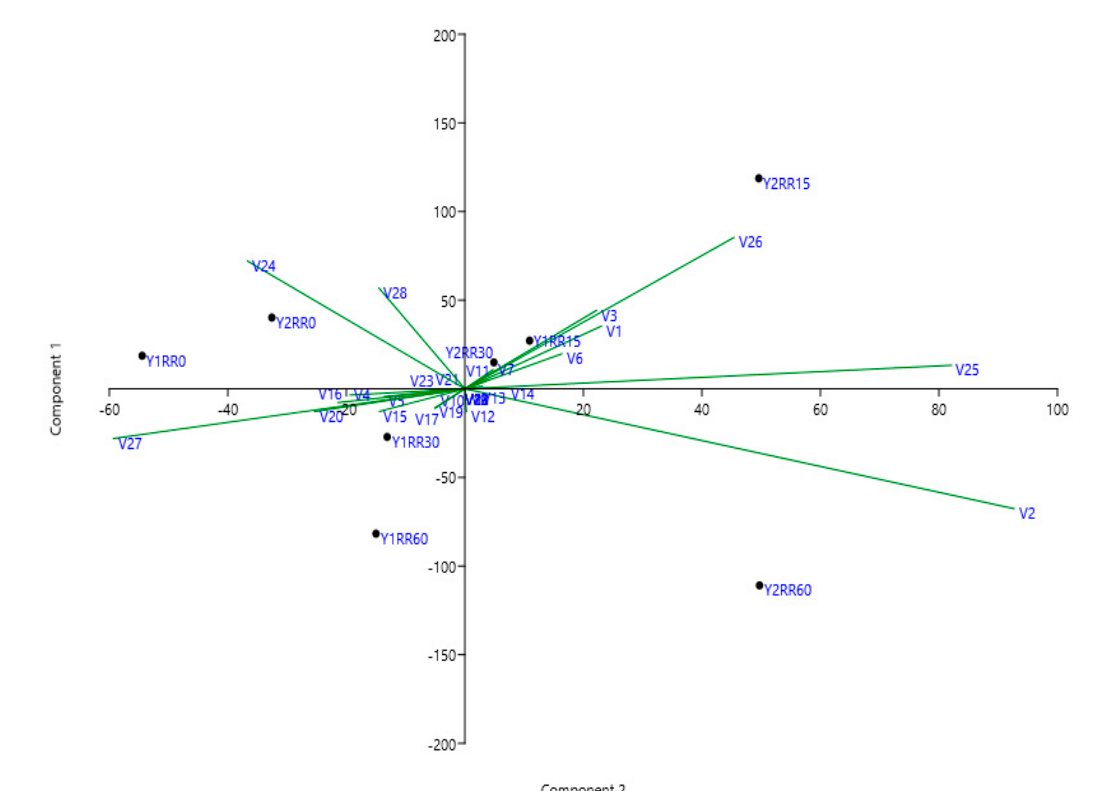
WP = weak perennial, P = perennial, Ave = average, + = appearing in one of the five replicates, ++ = appearing in two of the five replicates, +++ = appearing in three of the five replicates, ++++ = appearing in four of the five replicates, +++++ = appearing in all five of the five replicates.